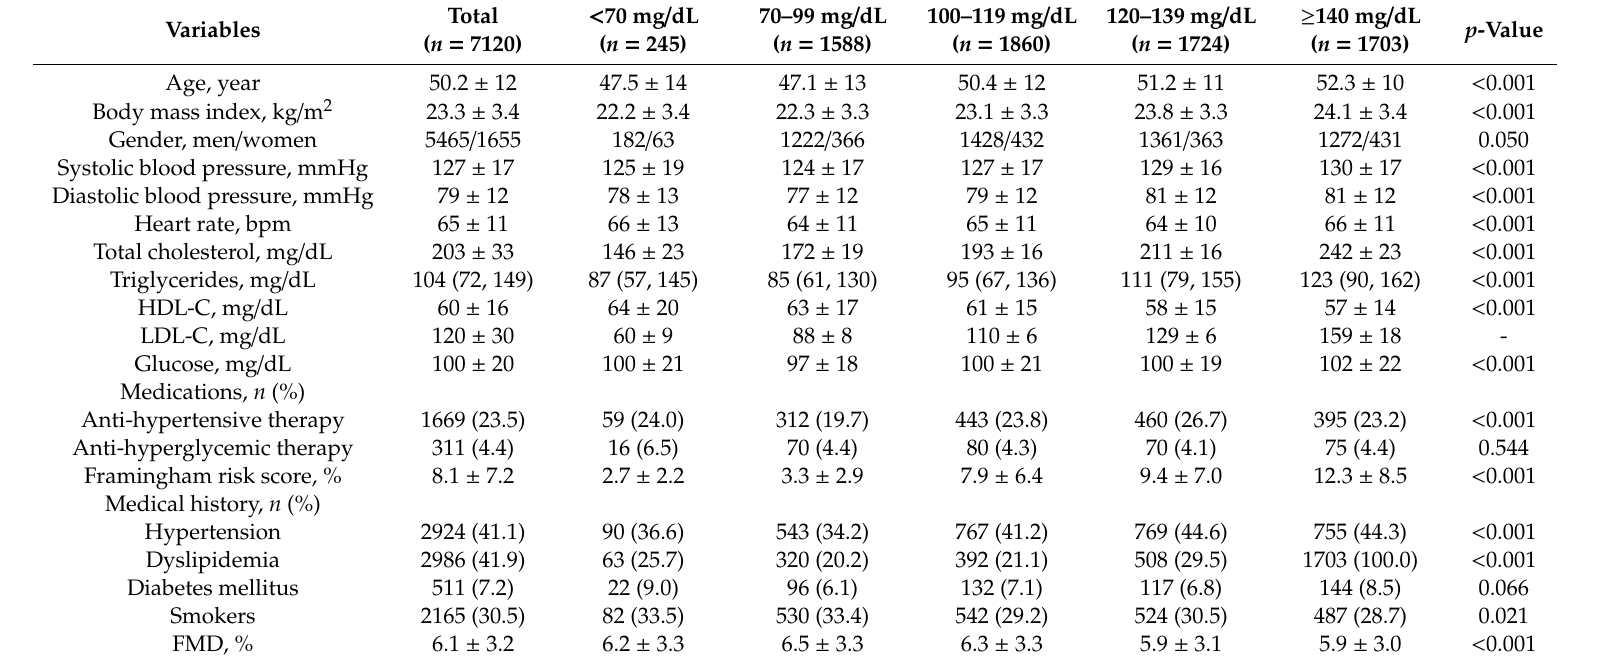
Table 1. Clinical characteristics of the subjects on the basis of